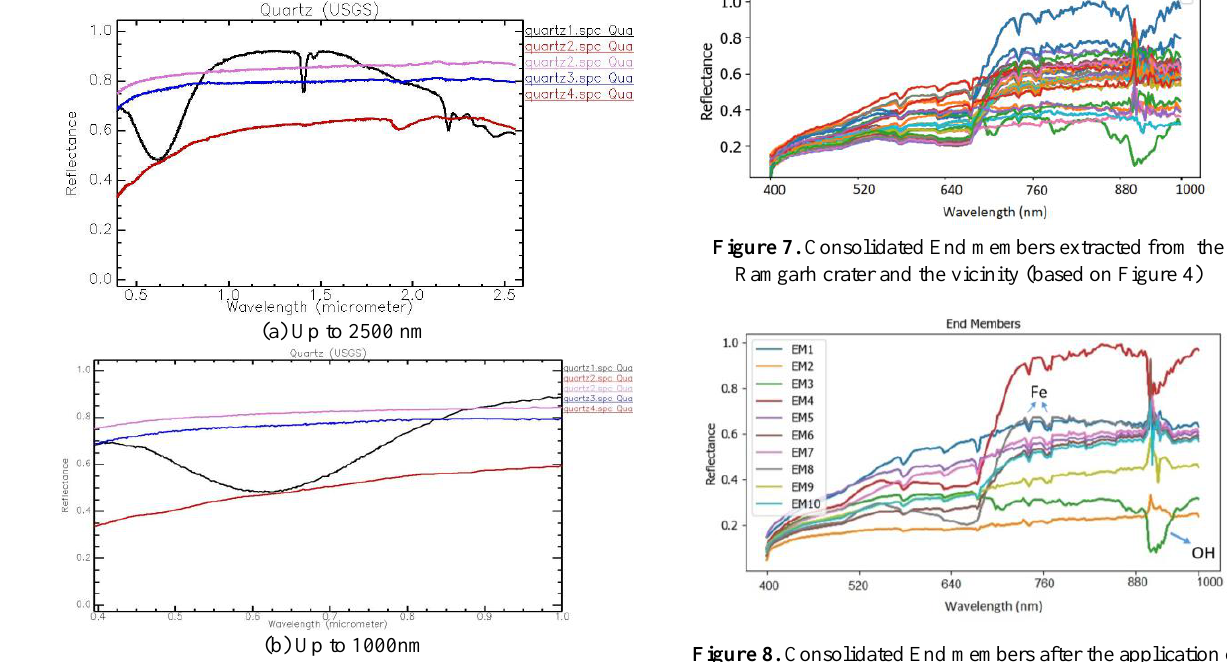
Figure 5. Quartz reference spectra (USGS)